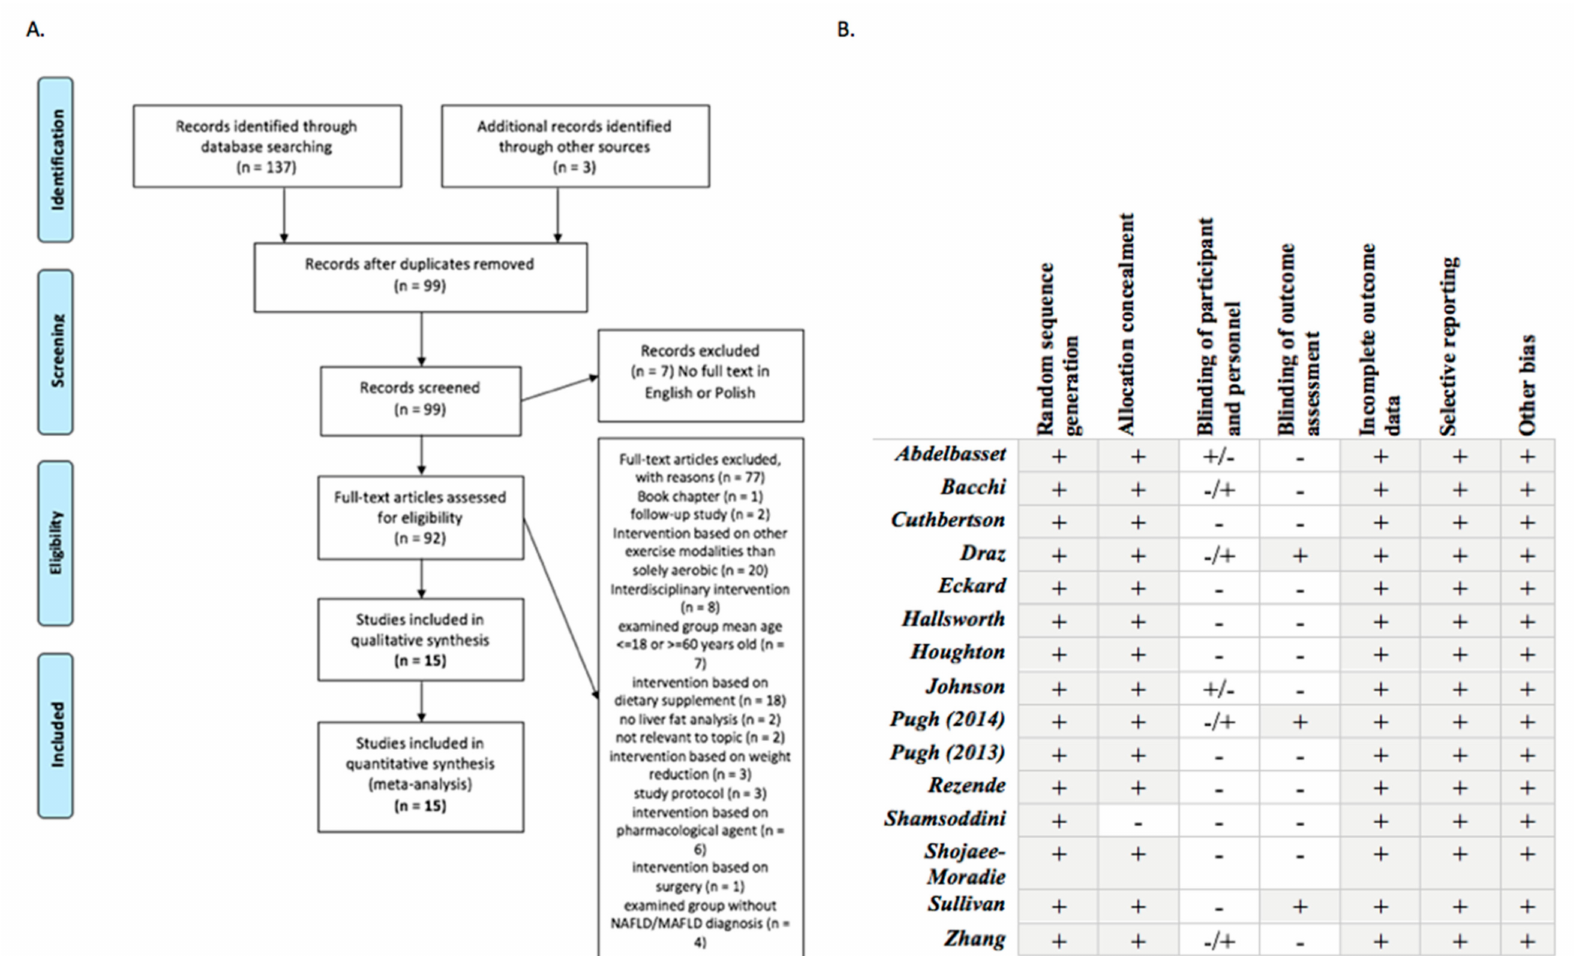
Figure 1. Flowchart of studies and critical appraisal. ( A ). Flow chart of the inclusion/exclusion process, according to the Preferred Reporting Items for Systematic Reviews and Meta-Analyses (PRISMA) statement [23]. ( B ). Quality of the trials and Cochrane risk bias